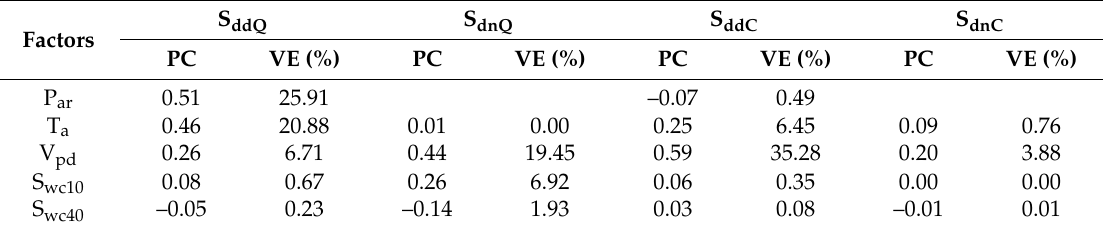
Table 5. Partial regression analysis of sap flow density versus various explanatory